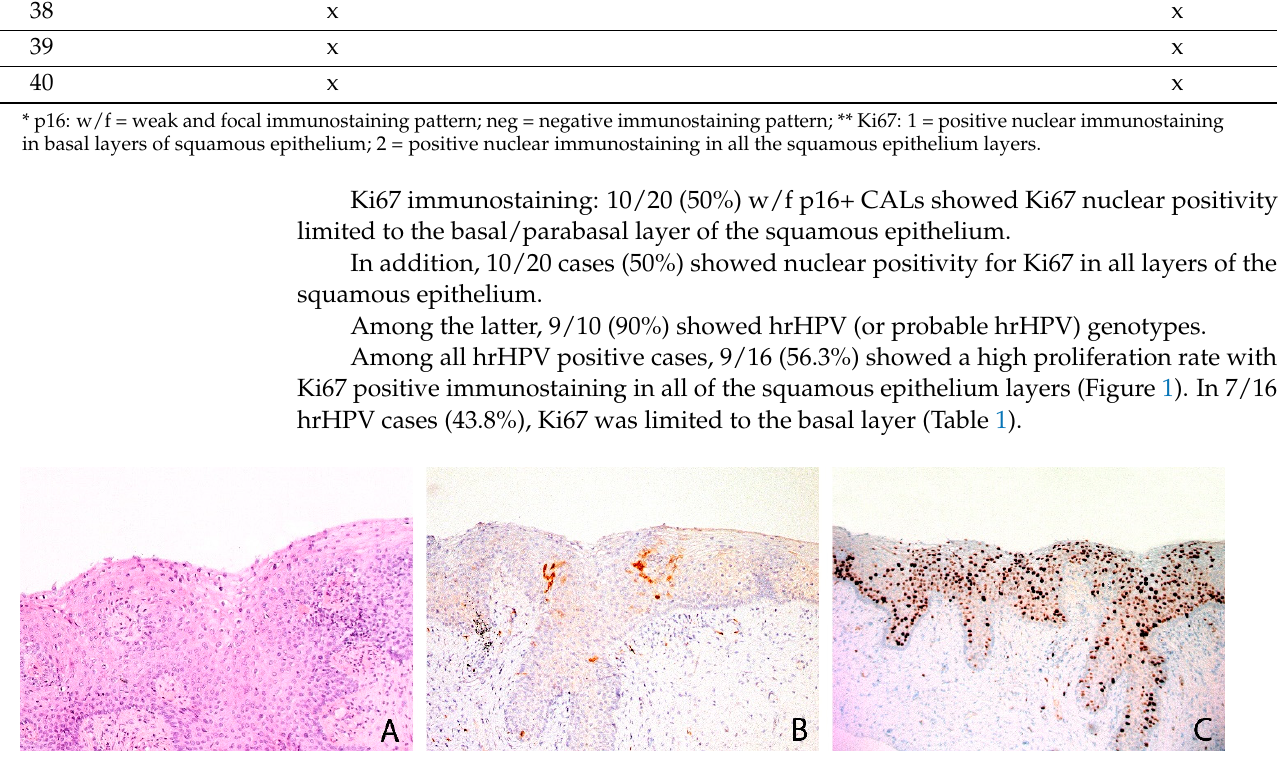
Figure 1. w/f p16+ CAL case showing koilocytic changes and mild epithelial atypia ( A ) with a focal positivity for p16 in few epithelial cells ( B ) and high proliferation rate with Ki67 positive immunostaining in all the squamous epithelium ( C ). A: Ematoxylin and eosin, 200×; B: p16 immunohistochemical stain, 100×; C: Ki67 immunohistochemical stain, 100×.